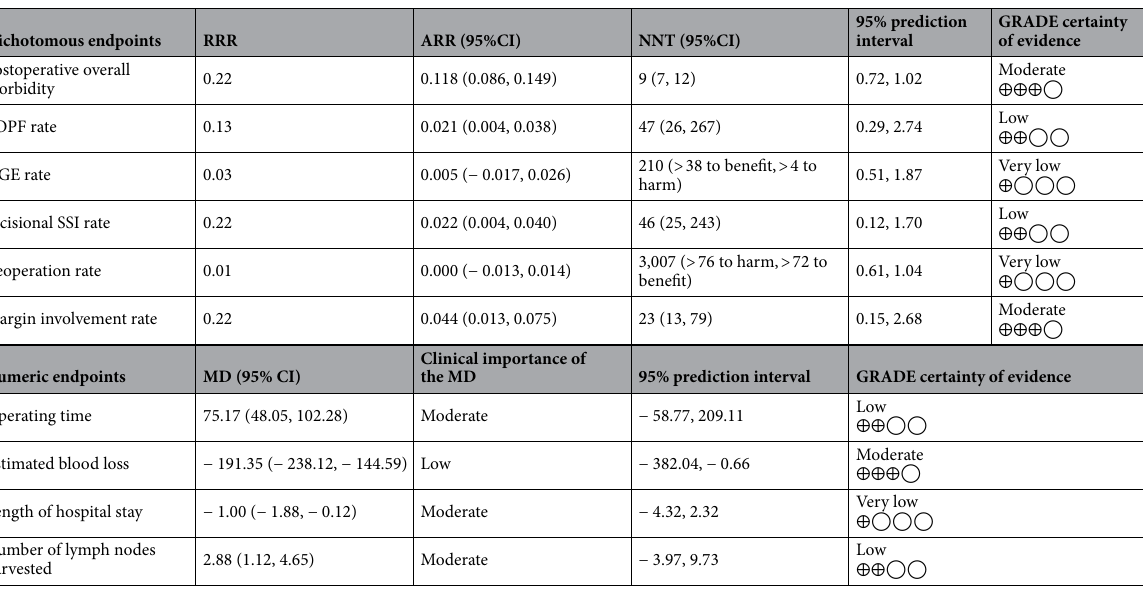
Table 4. Clinical relevance and certainty of evidence provided by statistical difference in clinical and pathologic endpoints (dichotomous and numeric) between robotic vs. open pancreaticoduodenectomy. RRR relative risk reduction; ARR absolute risk reduction; NNT numbers needed to treat; 95%CI 95% confidence interval; POPF postoperative pancreatic fistula; DGE delayed gastric emptying; SSI surgical site infection; MD mean